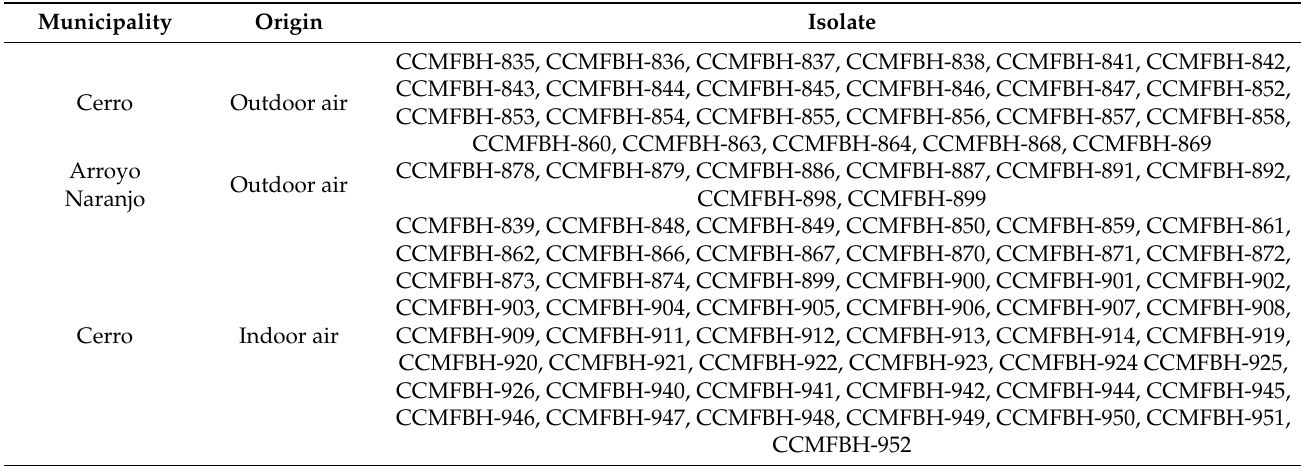
Table 1. Origin of the Aspergillus isolates from two municipalities of Havana,